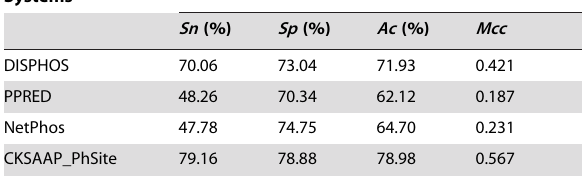
Table 6. Performance of DISPHOS, PPRED, NetPhos, and our predictors in terms of threonine (T) site prediction on the independent